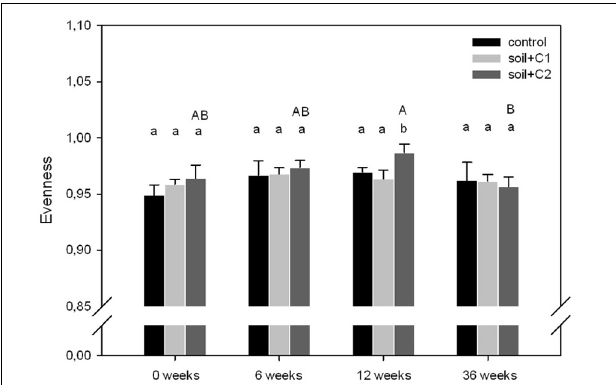
FIGURE 2 | Evenness of alkB gene harboring soil bacteria. Significant different treatments within one sampling time point are indicated with different lower case letters, the upper case letters indicate significant differences over time within one treatment ( n = 3, p -value < 0.05 based on ANOVA analysis, error bars indicate the standard deviation).